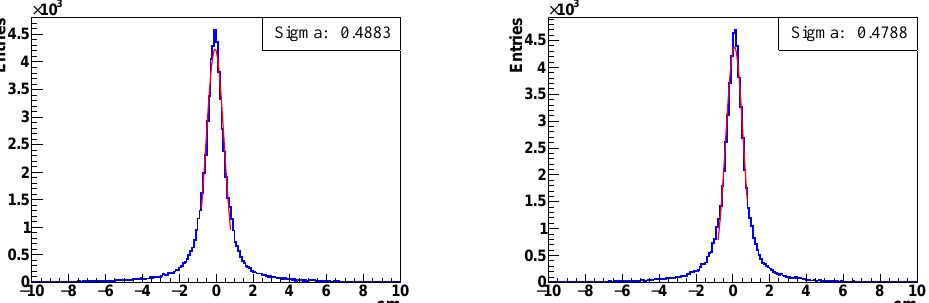
Figure 3. The di ff erence between the track coordinates from di ff erent pairs in the target area for the X coordinate (left) and for the Y coordinate (right). Sigma are 0.4883 and 0.4788